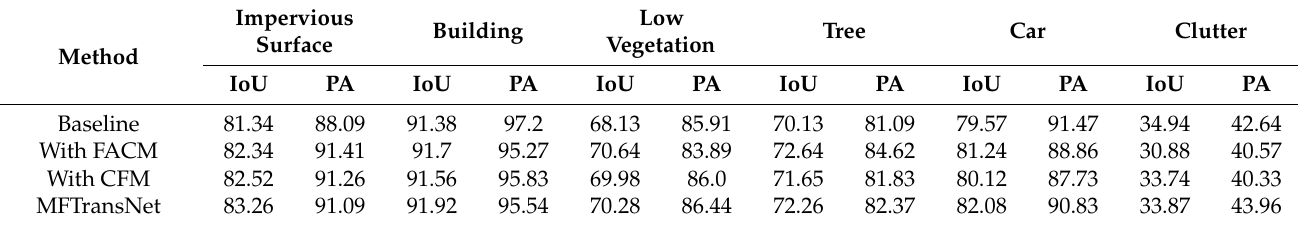
Table 6. Evaluation results for each